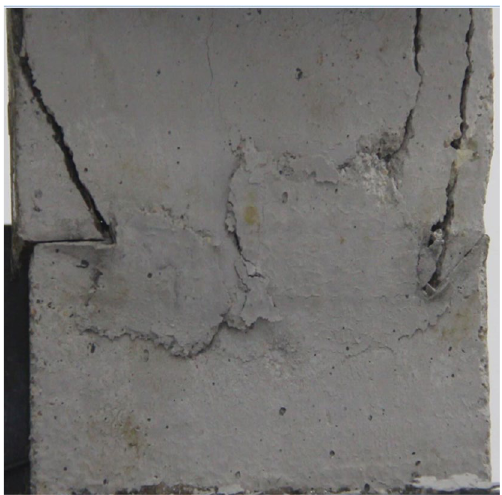
Figure 27. Photograph of a specimen showing transverse shear crack propagation.